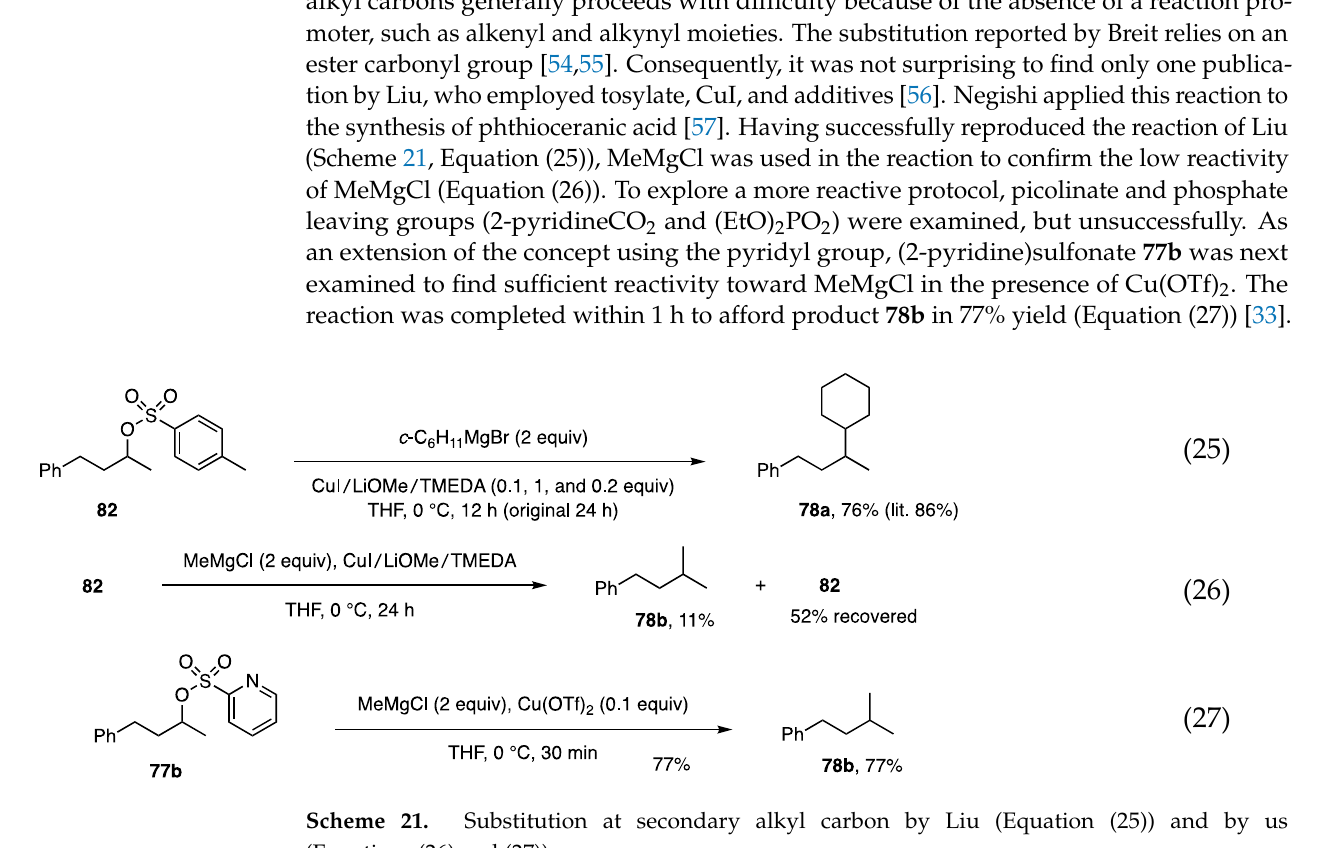
Scheme 21. Substitution at secondary alkyl carbon by Liu (Equation (25)) and by us (Equations (26) and